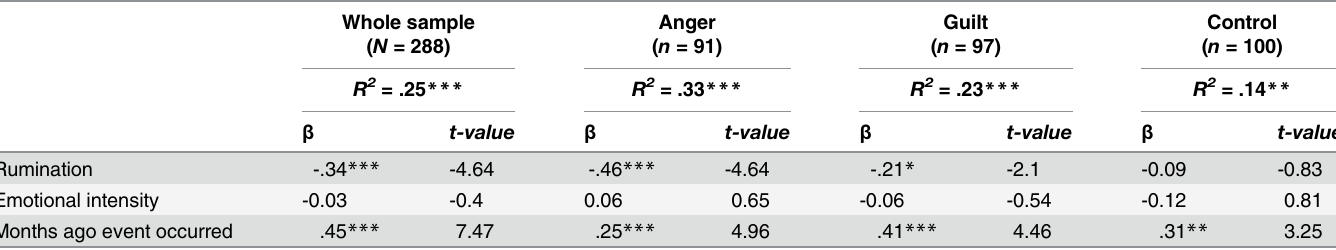
The left column represents the whole sample controlling for condition. Regression coef fi cients are